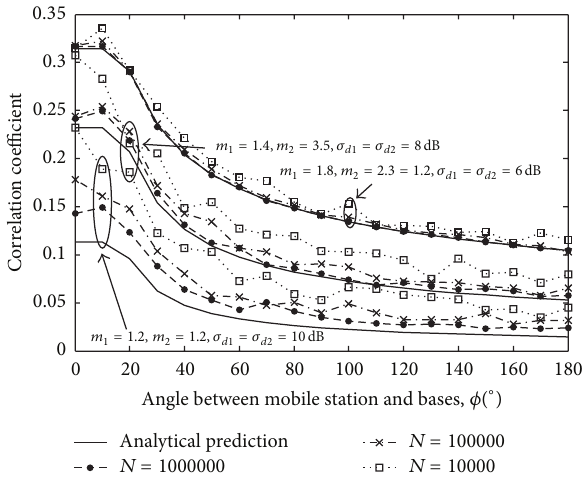
Analytical prediction N= 100000 N= 10000 N= 1000000 Figure5:Correlationcoefficientandmeanofthesamplecorrelation coefficient as a function of the angle between the mobile station and the two base stations. The parameters of the shadowing cross- correlation scenario are 𝑑 1 = 1000 m, 𝑑 2 = 2000 m, 𝑑 𝑐 = 300 m, and = 𝑚 = 1.2 , 𝛾 = 0.3 . The marginal distributions parameters are 𝑚 1 2 = 𝜎 = 10 dB; 𝑚 = 1.4, 𝑚 = 3.2 , 𝜎 = 𝜎 = 8 dB; and 𝜎 𝑑1 𝑑2 1 2 𝑑1 𝑑2 = 1.8, 𝑚 = 2.3 , 𝜎 = 𝜎 = 6 dB. The correlation coefficient 𝑚 1 2 𝑑1 𝑑2 (analytical prediction) is in solid lines and the mean of the sample correlationcoefficientindashedlines.Thenumberofobservationsis 𝑁 = 10000, 100000, 1000000 and the number of samples is 𝐾 = 50 .